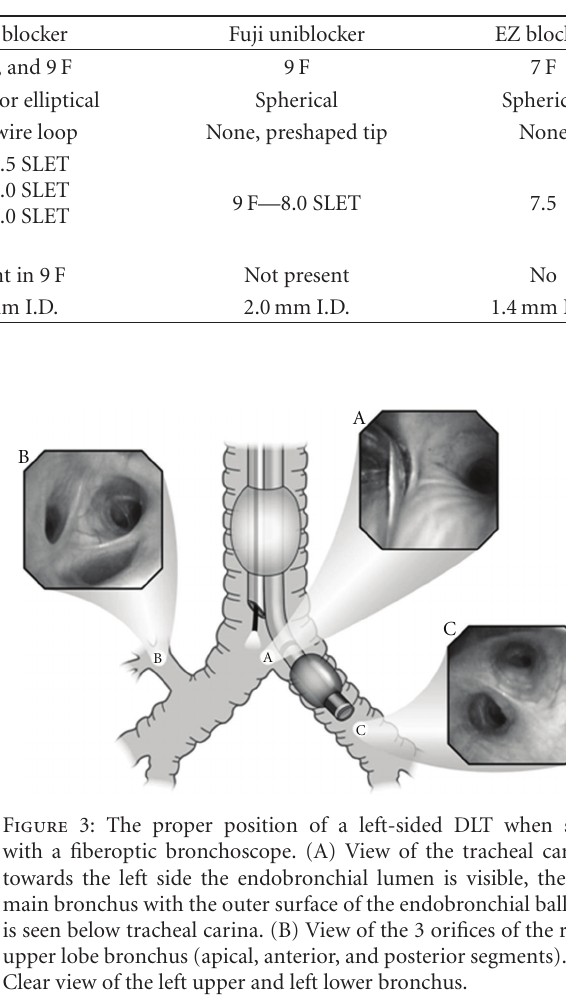
Table 1: Characteristics of the bronchial blockers.